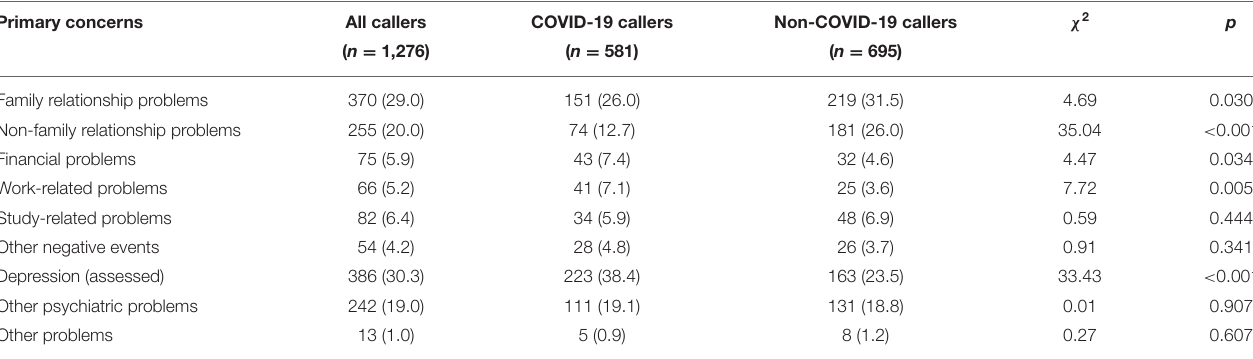
TABLE 2 | Comparison of the primary concerns reported by COVID-19 callers and non-COVID-19 callers [ n